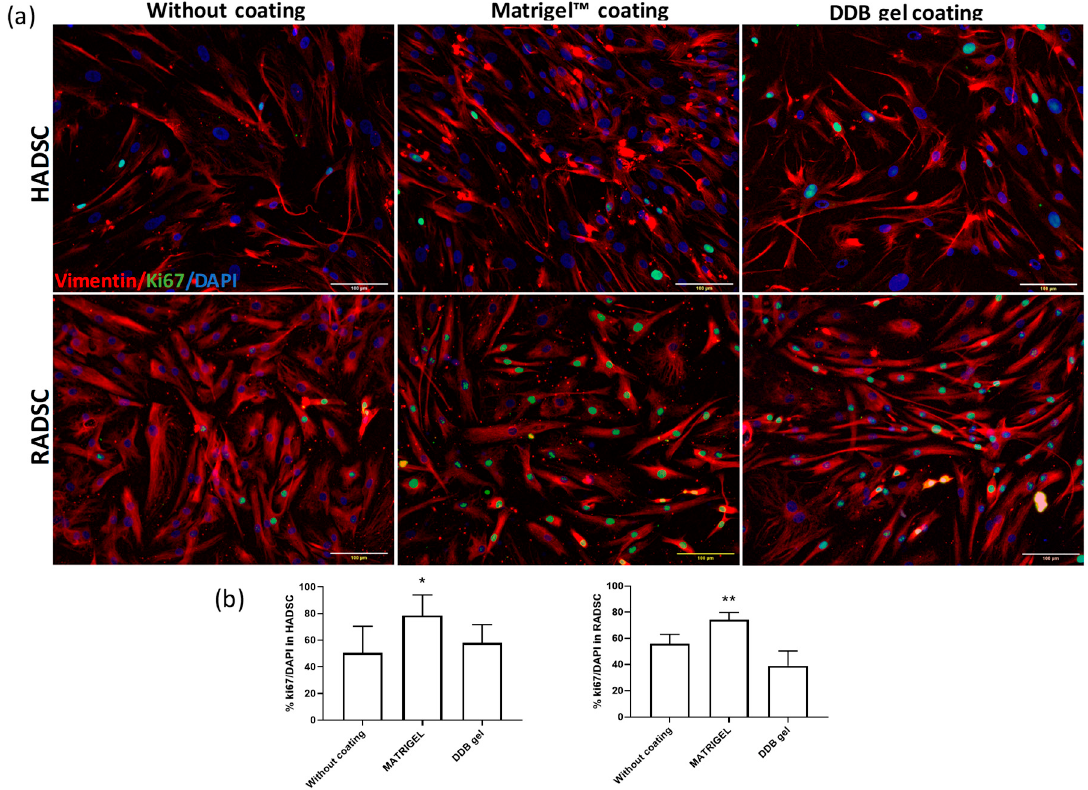
Figure 4. DDB coating does not accelerate cell proliferation. ( a ) Rabbit ADSC (RADSC) and human ADSC (HADSC) were grown for 72 h on coverslips without coating or covered with Matrigel or coated with DDB gel and then were subjected to double immunostaining of Ki67, a mitotic marker (green), and Vimentin, a cytoskeleton filament (red). DAPI (blue) was used for nuclei counterstaining. ( b ) Quantification of the proliferating cells measured by the percentage of Ki67 positive cells; n = 3; * p > 0.05, ** p > 0.01 versus without coating.